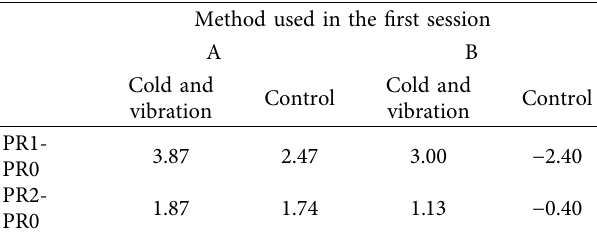
Table 2: Mean difference of heart rate (before and during) and (before and after) infiltration in groups A and